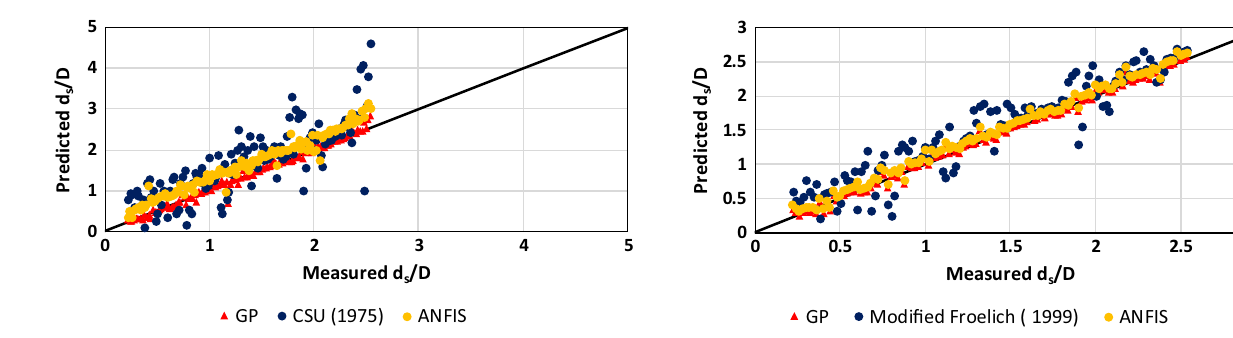
D versus Modified s /